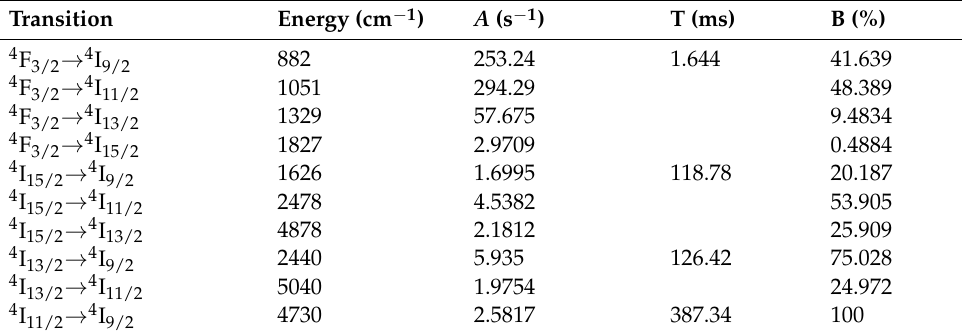
Table 3. Spectroscopic parameters of the PZLBNdYb glass system. Transition Energy (cm − 1